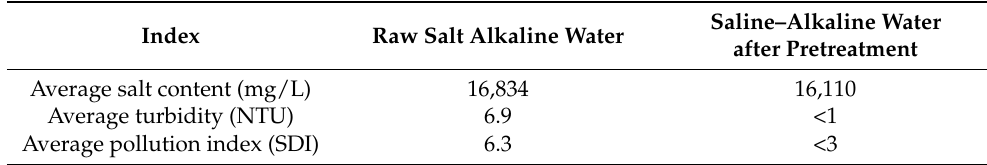
Table 2. Change in the quality of the saline–alkali water.